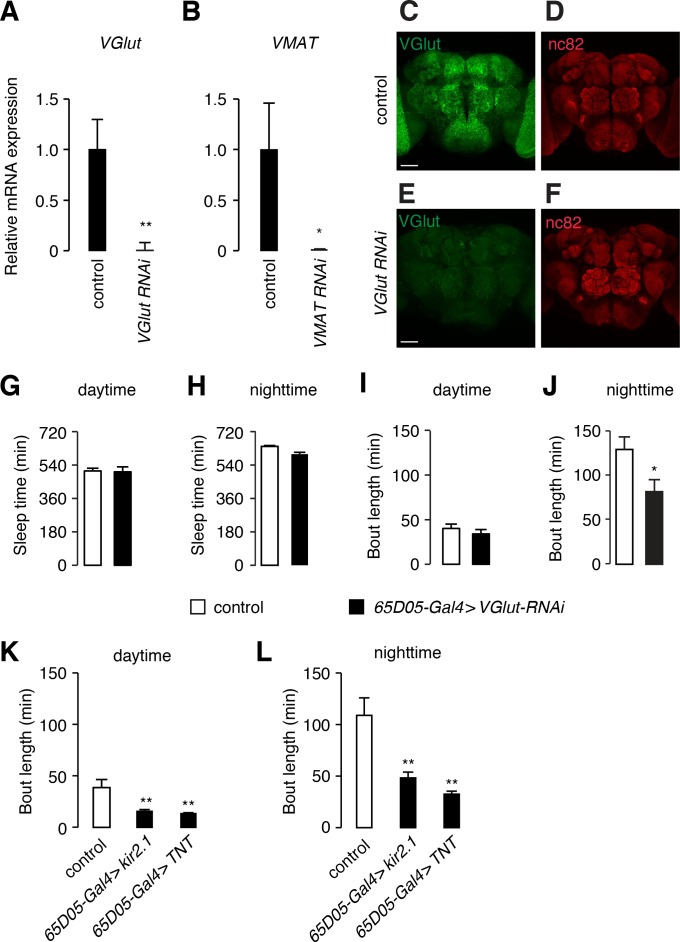
RNAi knock-down of VGlut and VMAT.(A, B) Quantification of VGlut and VMAT mRNA expression assessed by quantitative real-time (RT) PCR. Total RNAs were extracted from control flies (w1118) or flies expressing the indicated UAS-RNAi transgene in all neurons under control of the elav-Gal4, and used for reverse transcription. Expression of VGlut or VMAT RNAs was quantified by RT-PCR. Error bars, SEMs. *p < 0.05, **p < 0.01. For VGlut RT-PCR: n = 4 for control flies, and n = 5 for VGlut RNAi. For VMAT RT-PCR: n = 5 for control flies, and n = 5 for VMAT RNAi. (C, D) A whole-mount control brain immunostained with anti-VGlut (green) and anti-nc82 (red). (E, F) A whole-mount brain that expressed VGlut-RNAi in all neurons immunostained with anti-VGlut (green) and anti-nc82 (red). (G–L) Quantification of parameters of daytime and nighttime sleep of the indicated flies. 65D05-Gal4/+served as the control. (G, H) Total sleep. (I—L) Bout length. Error bars, SEMs. *p < 0.05, **p < 0.01. Unpaired Student’s t-test for G—J, and one way ANOVA with Dunnett’s test for K and L. In panels G—J, n = 27 for the control, and n = 12 for 65D05-Gal4 > VGlut RNAi. In panels K and L, n = 32 for the control, n = 27 for 65D05-Gal4 > kir2.1, and n = 29 for 65D05-Gal4 > TNT.